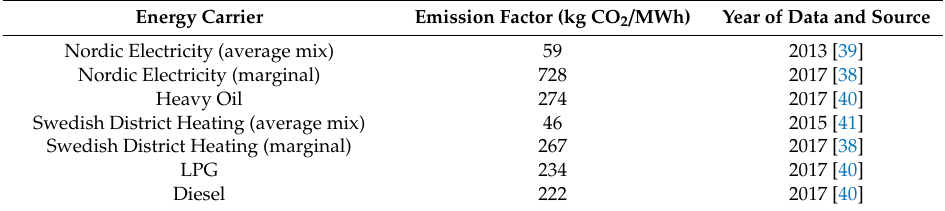
Table 2. Emission factors for di ff erent energy carriers considered for this